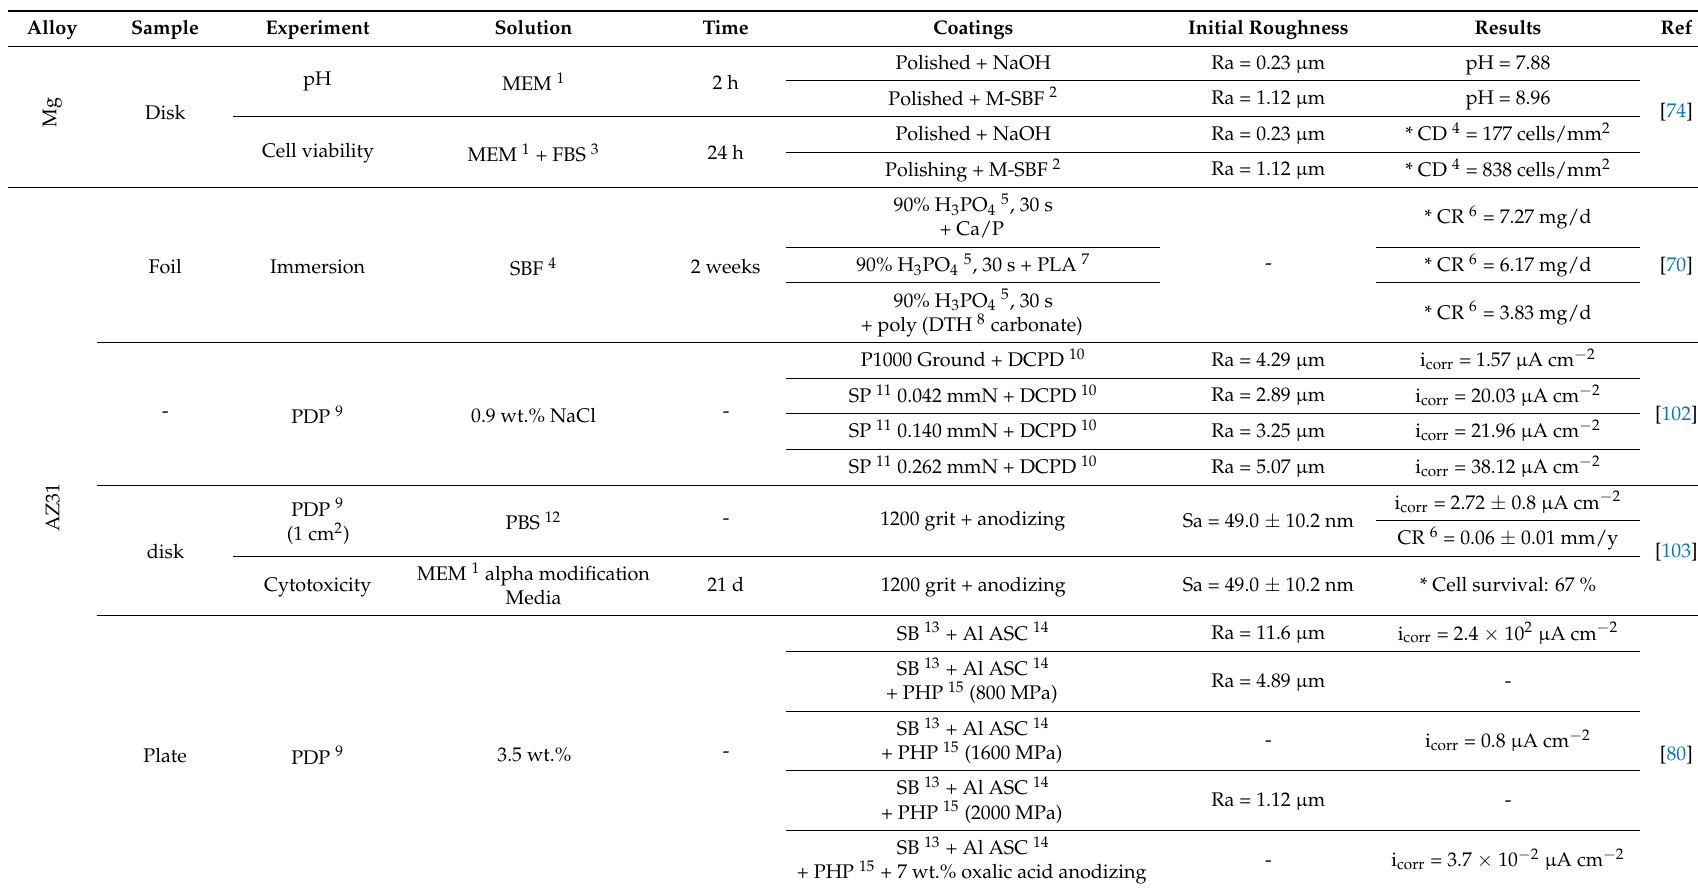
Table 4. Overview of different Coatings studies involving roughness and degradation behavior. * Values were determined from the diagram with the corresponding